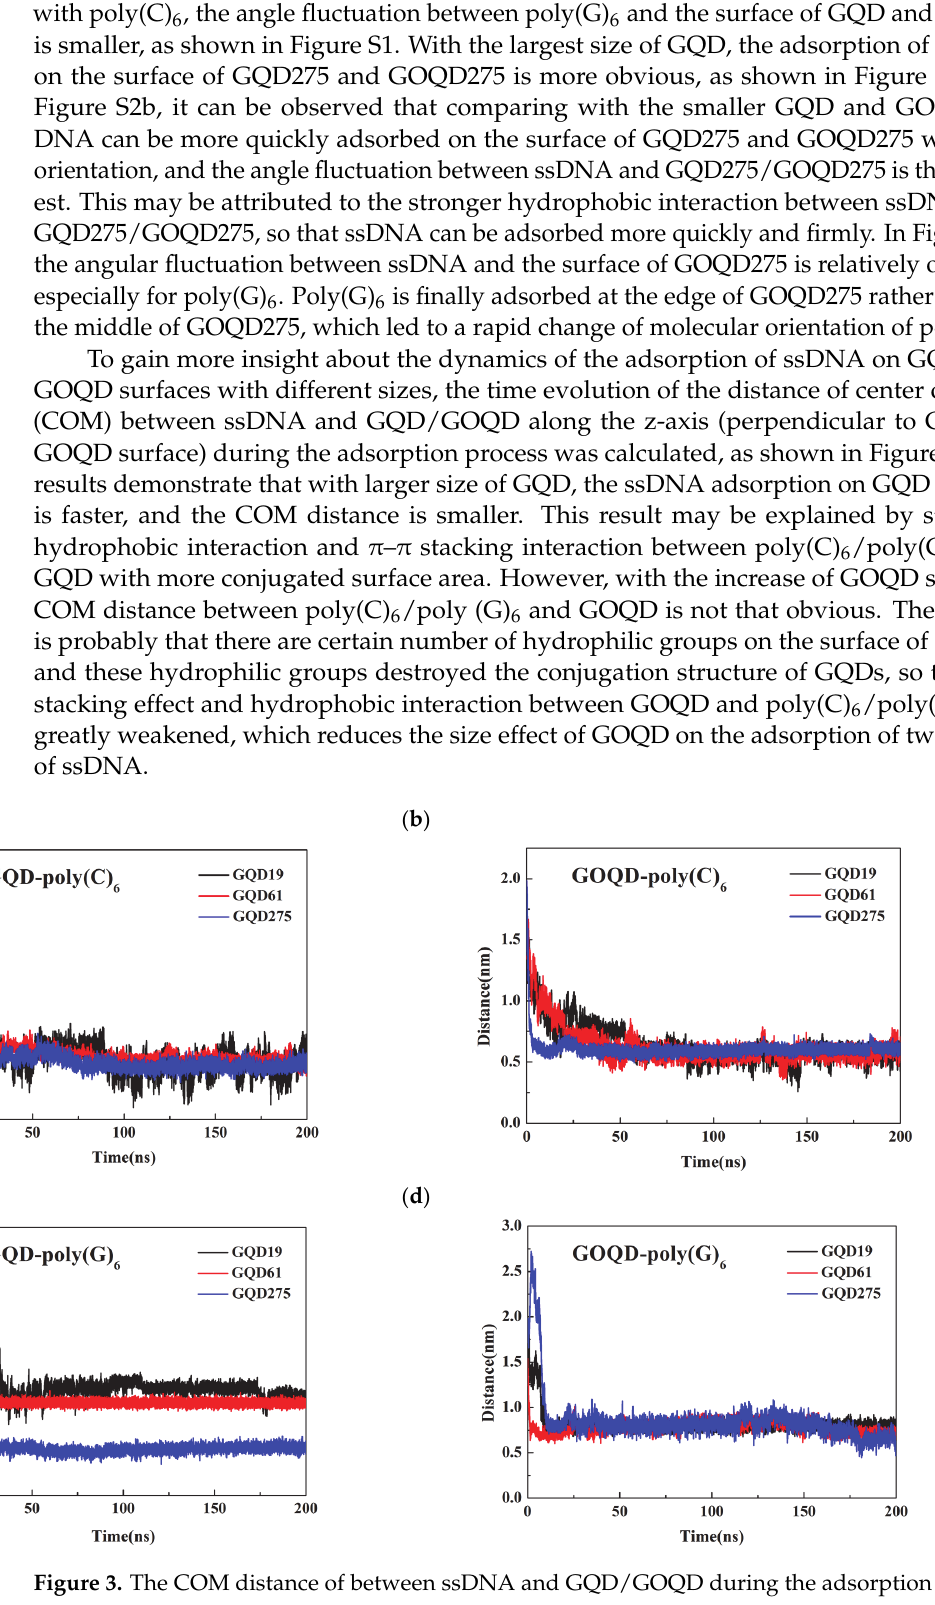
Figure 3. The COM distance of between ssDNA and GQD/GOQD during the adsorption process: